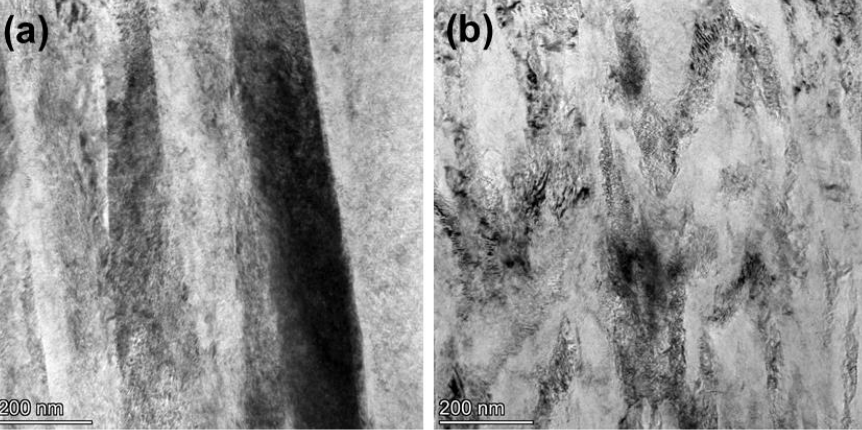
Figure 7. Cross section TEM micrographs of the TiAlN coating: nitrogen flux rate of ( a ) 40 sccm, ( b )